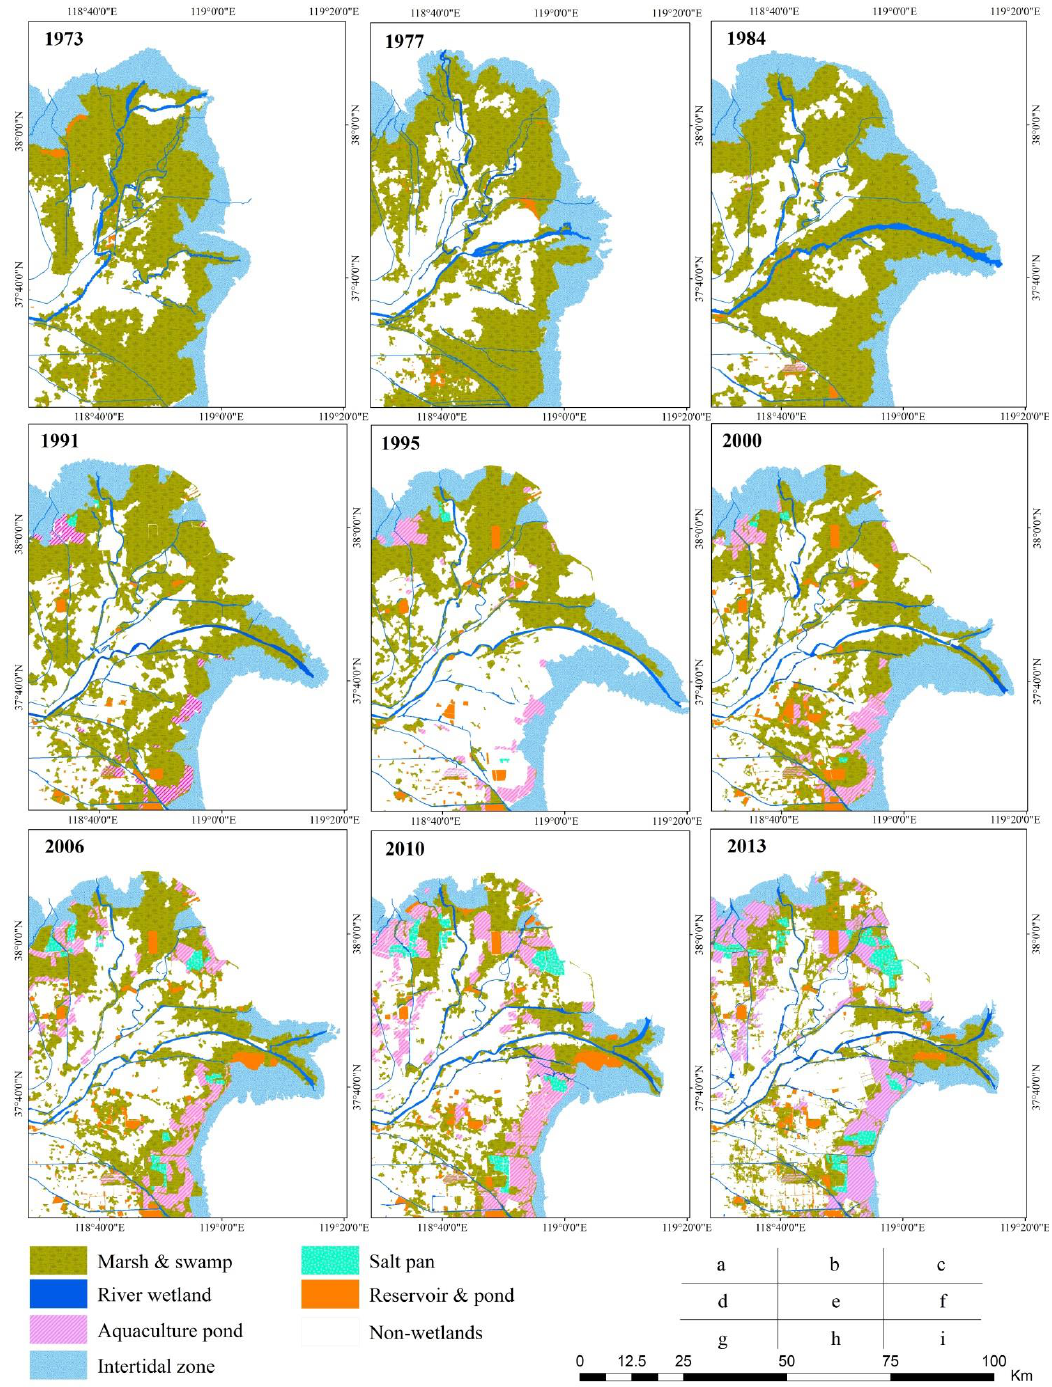
Figure 4. A time series of wetland distribution in the Yellow River Delta from 1973 to 2013. Maps were created using remote sensing.